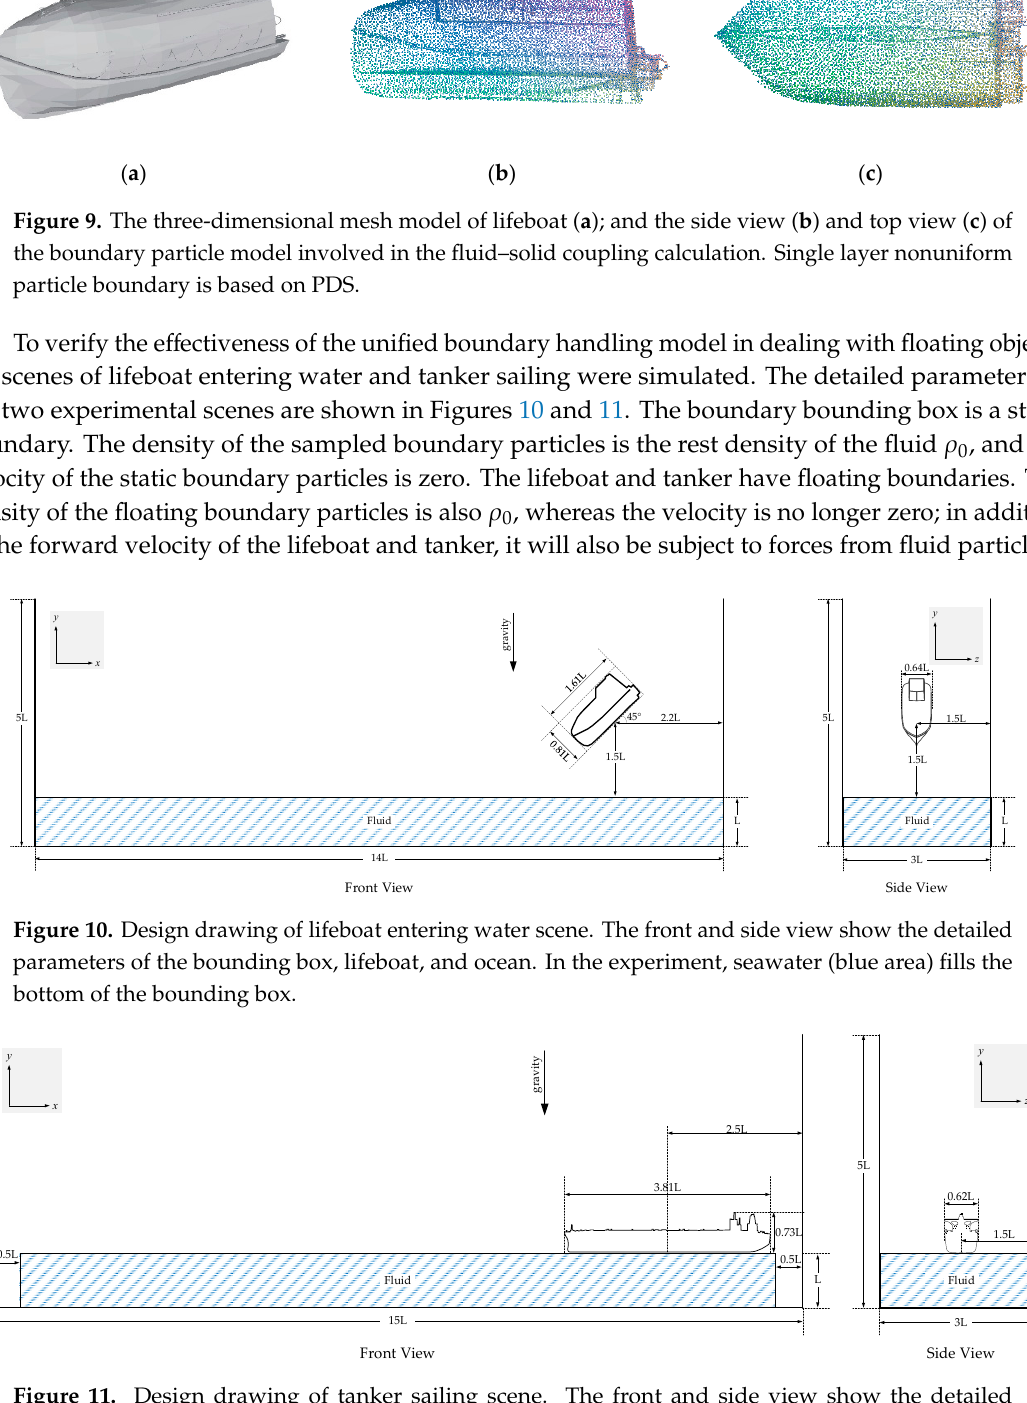
Figure 11. Design drawing of tanker sailing scene. The front and side view show the detailed